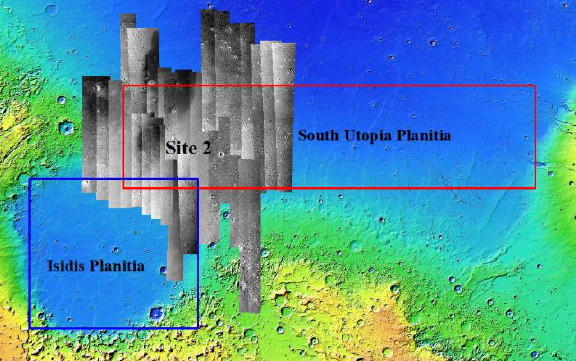
Figure 2. Test data in one of the potential landing areas of China’s first Mars exploration mission. The red and blue rectangles indicate the potential landing areas in the South Utopia Planitia and Isidis Planitia respectively.